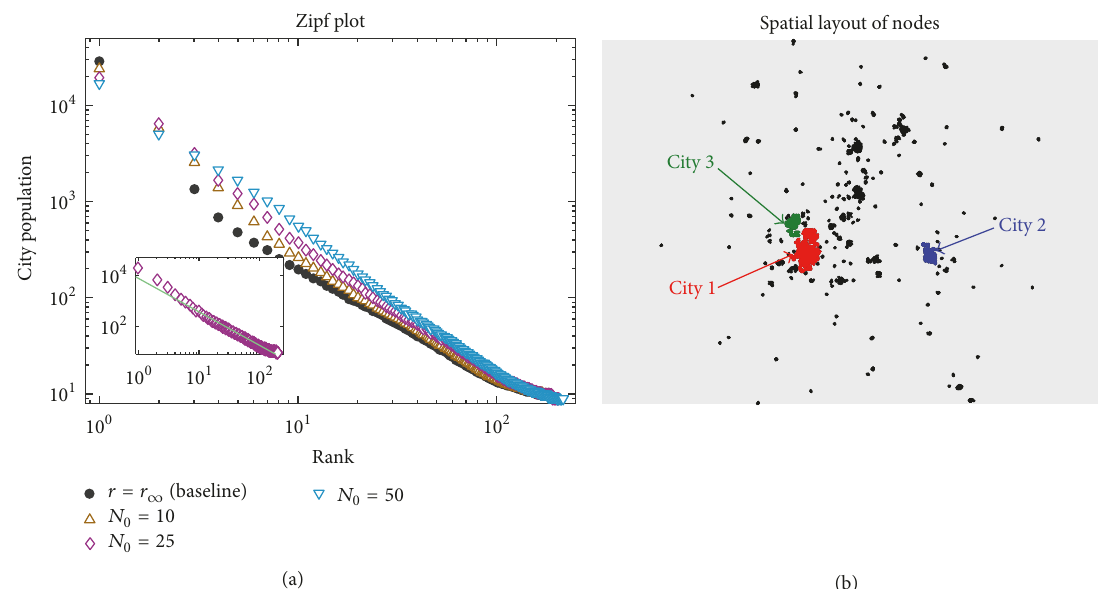
Figure 2: (a) Effect of 𝑁 0 on the distribution of city sizes by rank, on a log-log scale. The inset highlights the case of 𝑁 0 = 25 that we use for our simulations. The fitted straight line has slope ≈ −1.32 . (b) Spatial layout of a network of 𝑁 = 51200 nodes generated with 𝑁 0 = 25 . For visual clarity, we divide the spatial domain into 200 -by- 200 equal-size square boxes (cells) and show only the nodes in populated cells, which are those with a population exceeding the average (per nonempty box). The three largest “cities” are color-coded in red (pop. 15,072), blue (pop. 5,567), and green (pop. 3,743). As noted in the main text, the cities were identified by the spatial City Clustering Algorithm as developed in [27], where the populated cells (boxes) are defined as